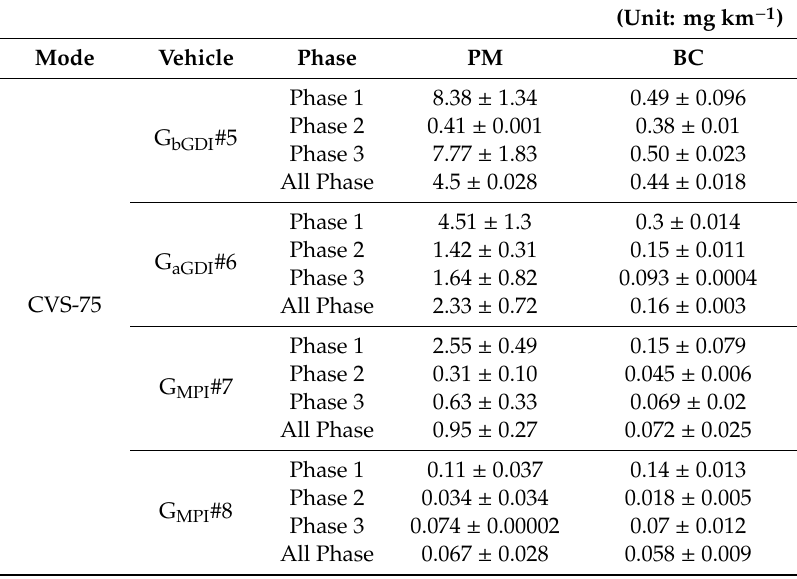
Figure 6. BC emission from gasoline vehicles according to di ff erent types of engines and PM regulations. ( a ) the result of vehicles tested in 5 di ff erent NIER modes, ( b ) the comparison of BC emission from di ff erent fuel types in the CVS-75 mode. Table 5. PM and BC emissions from gasoline vehicles with di ff erent types of engines and PM regulations in the CVS-75 mode.